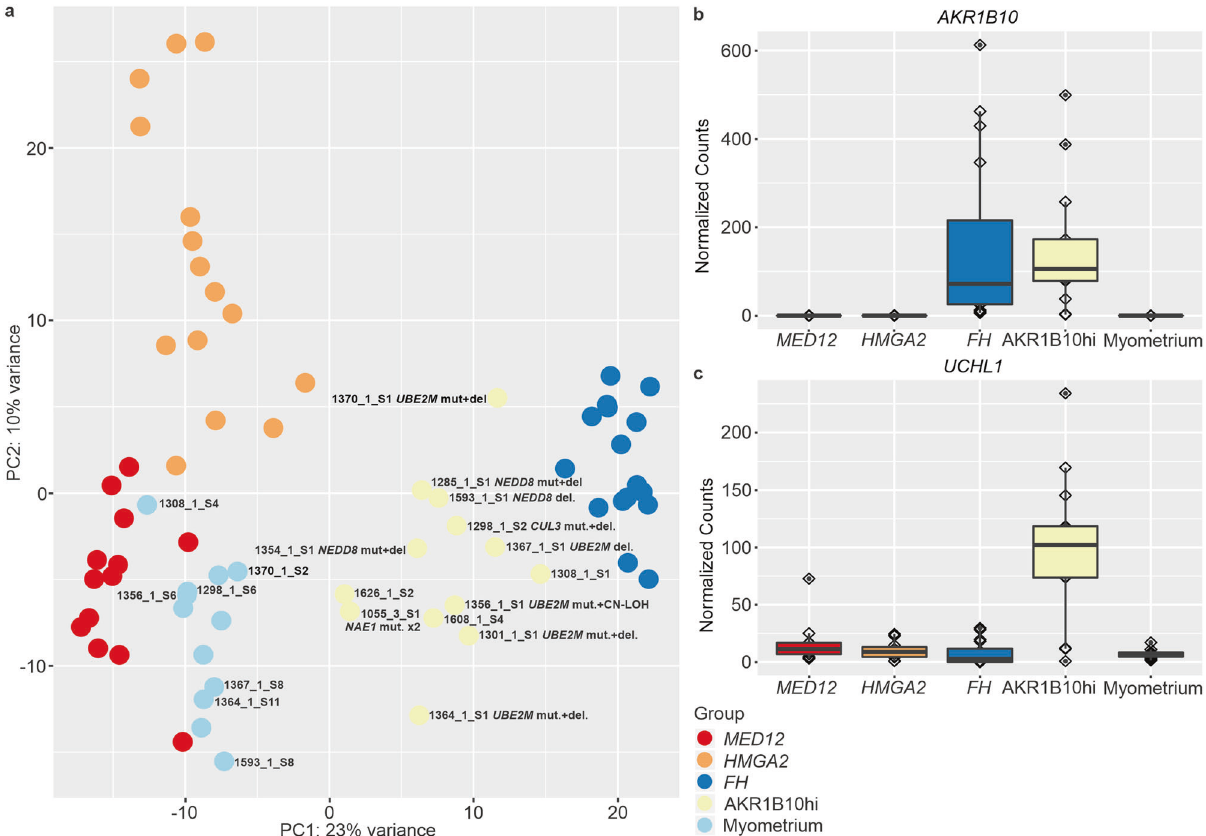
Fig. 3 Principal component analysis and differentially expressed genes in AKR1B10hi leiomyomas. a Thirteen AKR1B10hi leiomyomas and seven corresponding myometrium samples were analyzed together with a previously published dataset of 44 leiomyoma and 5 myometrium samples. Principal component analysis revealed that the AKR1B10hi samples cluster separately from leiomyomas of the MED12 , HMGA2 , and FH subtypes. Samples analyzed in this study are marked with sample identi fi ers. b AKR1B10 was signi fi cantly upregulated in AKR1B10hi and FH-de fi cient leiomyomas, but not in the other leiomyoma subtypes. c Deubiquitination gene UCHL1 was among the most uniquely upregulated genes in AKR1B10hi